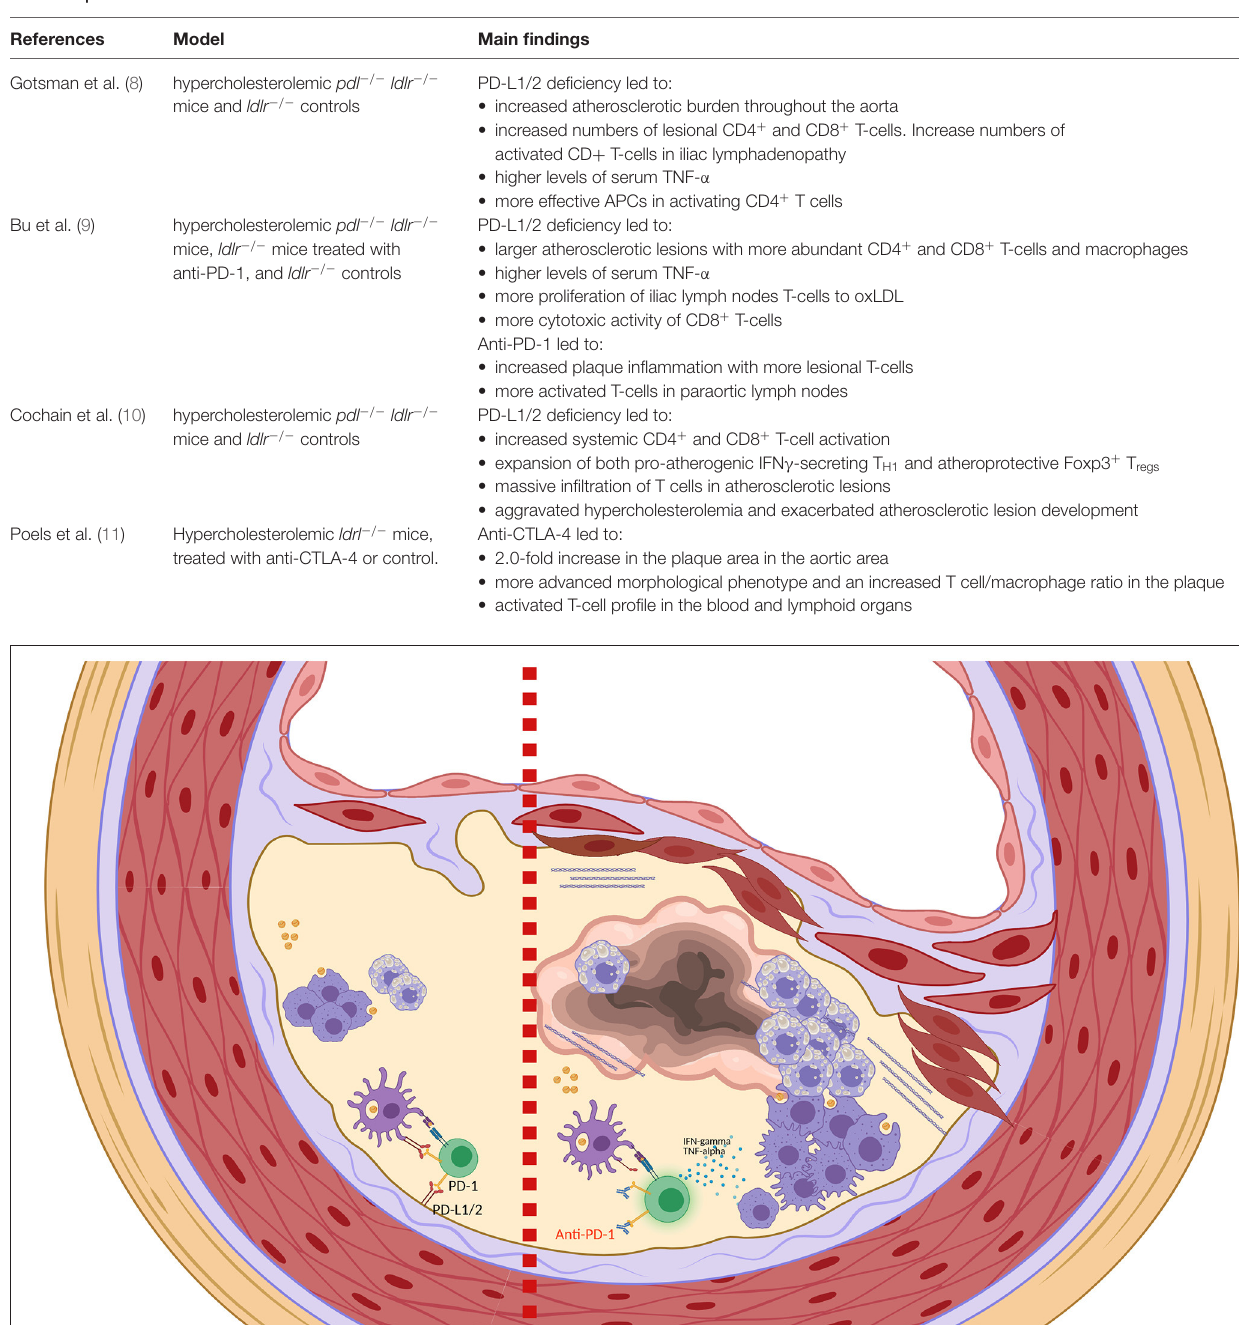
TABLE 1 | Preclinical studies.